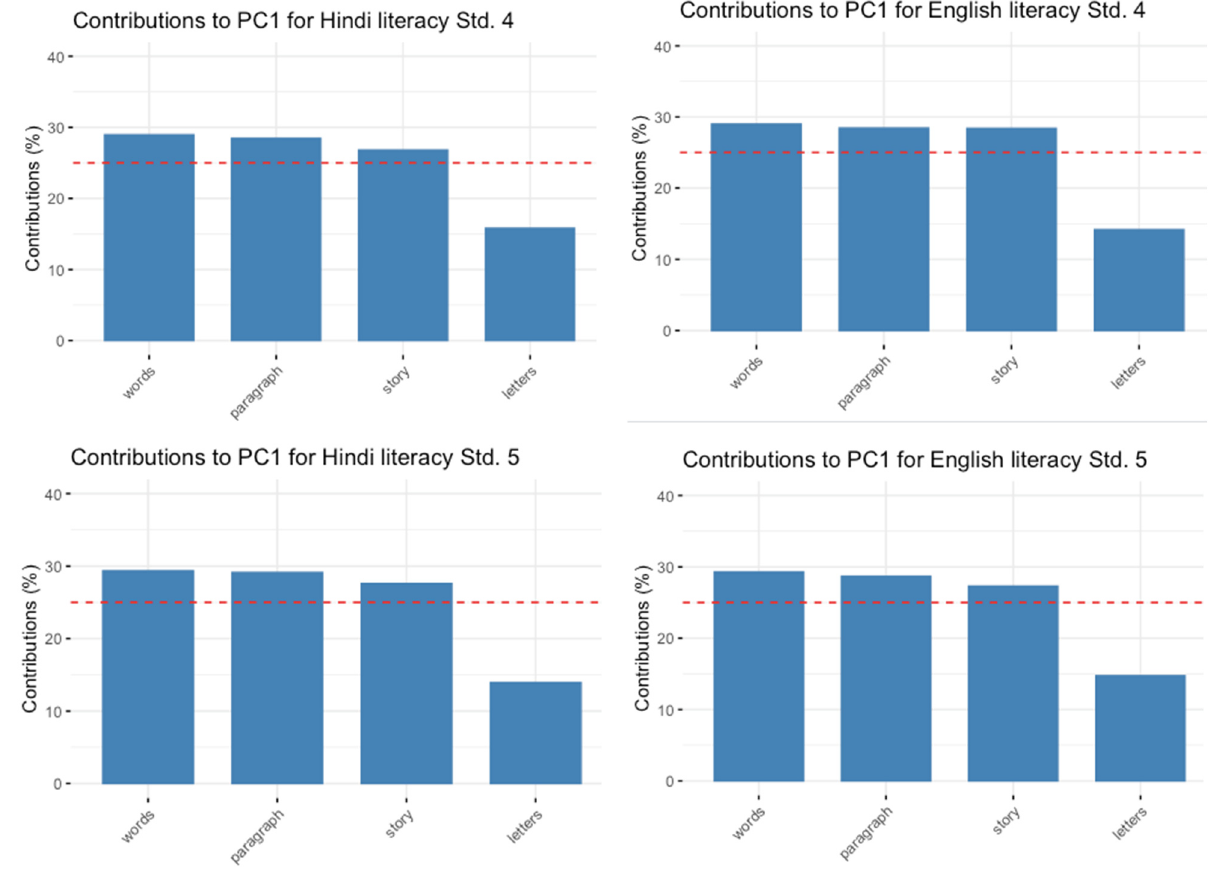
Figure A2. Contribution of variable to each of the first principal components for the literacy data. The order of the contribution of components is the same for both time points and both languages.